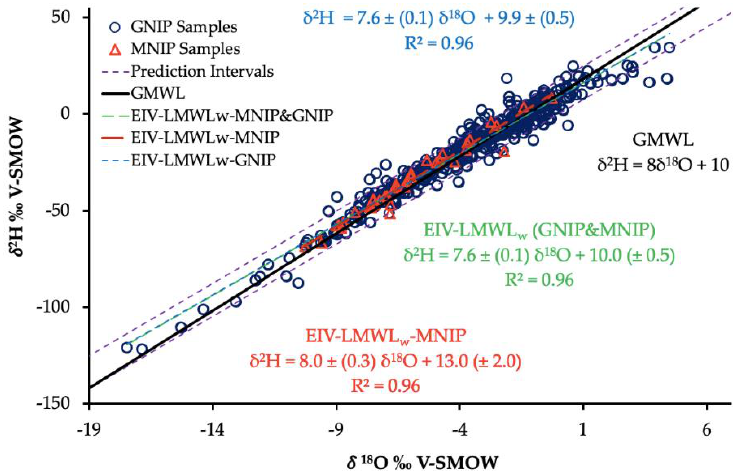
Figure 4. Plot of δ 2 H and δ 18 O for precipitation stable-isotopic samples from MNIP stations (n = 37) and GNIP stations (n = 409). Error–in–variables local meteoric water line (EIV–LMWLw) represents the weighted local meteoric water line calculated based on error–in–variables regression analysis. MNIP: Malawi network of isotopes in precipitation; GMWL: Global Meteoric Water Line.